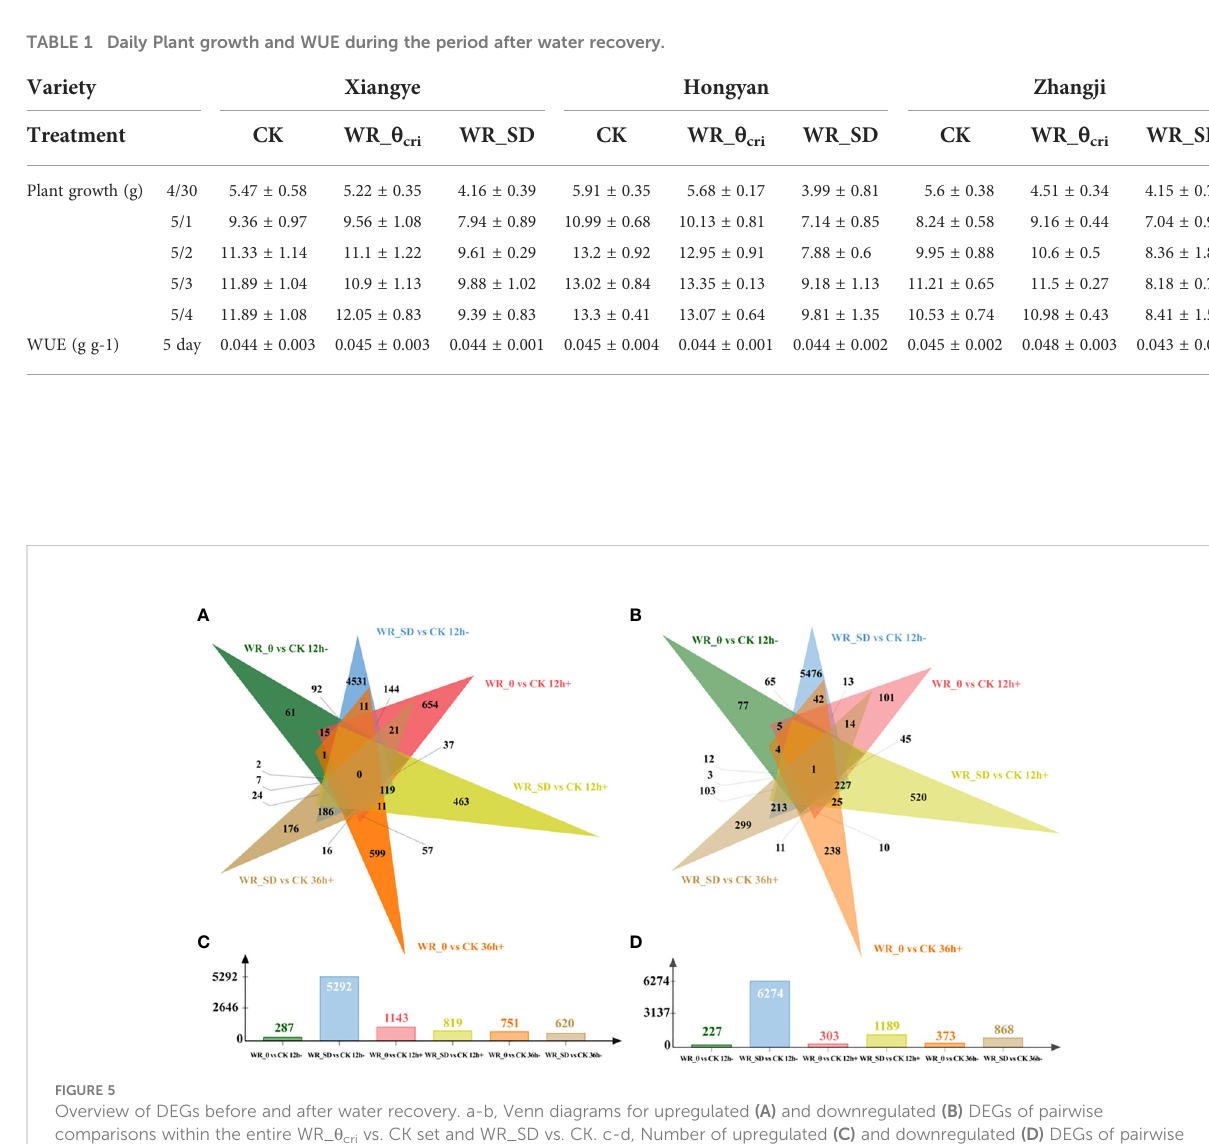
and Zhangji (~16%, Figure 4C), while there was the largest gap between the E values of WR_SD and CK for Zhangji (reduced by ~32%, Figure 4F), followed by Hongyan (~17%, Figure 4D) and Xiangye (~16%, Figure 4E). Daily plant growth (fresh weight, g) was also detected nondestructively by the “ Plantarray ” system during the water recovery phase, and water use ef fi ciency (WUE) during the 5-day window after water recovery was also calculated by accumulated plant growth and E. The daily plant growth of WR_SD during the water recovery phase was signi fi cantly lower than WR_ q cri and CK in all three varieties, mainly due to the daily